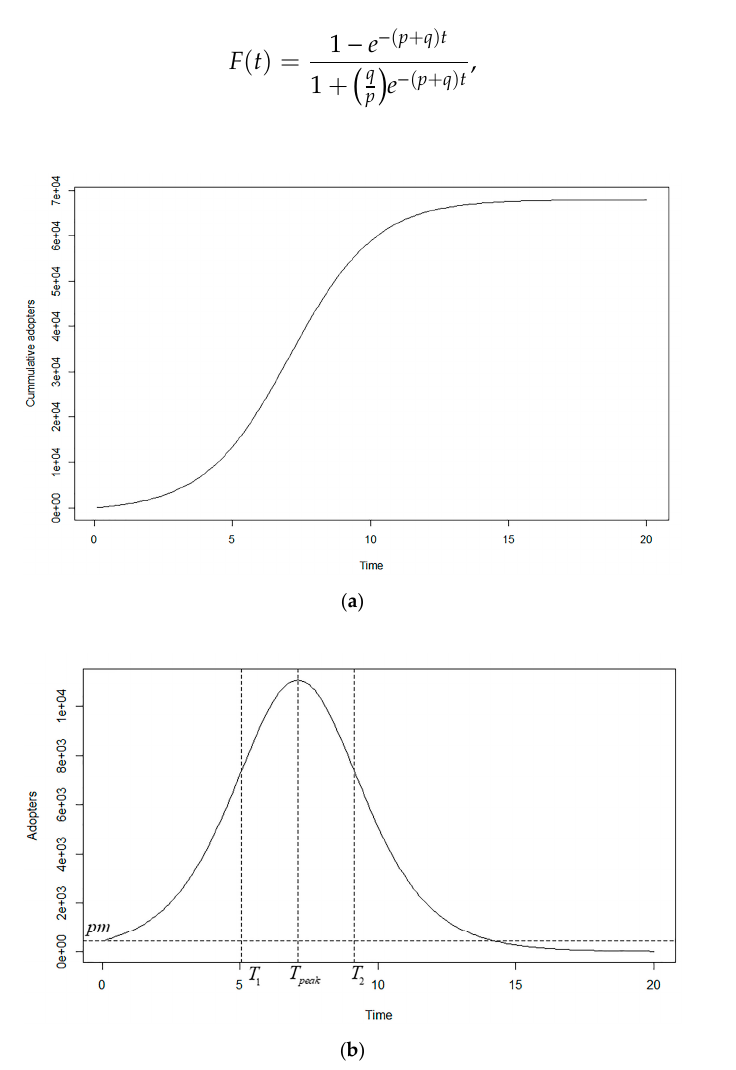
Figure 1. ( a ): Cumulative distribution function curve of the Bass model. ( b ): Probability density function curve of the Bass model.